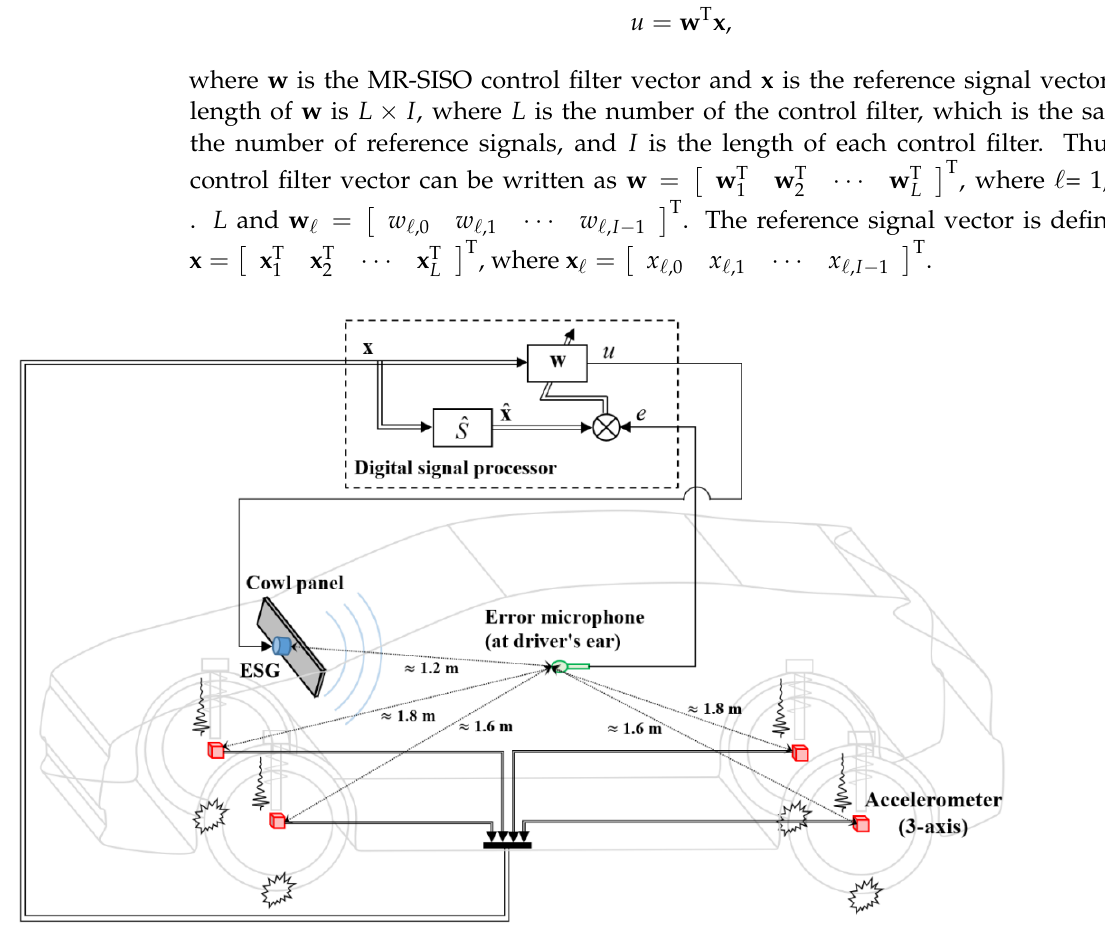
Figure 2. Illustration of an MR-SISO ARNC system with an ESG attached to the cowl panel using an FxLMS strategy.